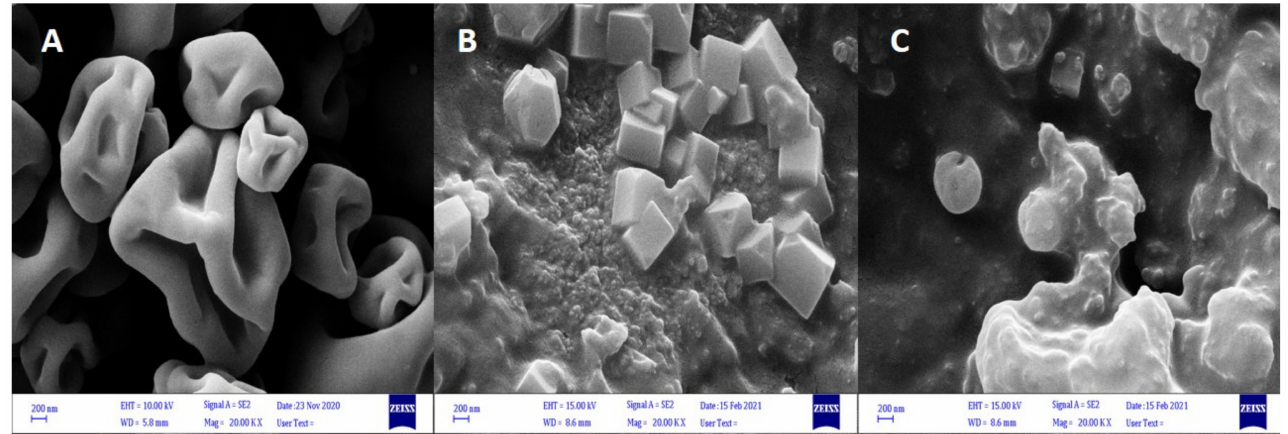
Figure 1. SEM micrographs of sodium alginate–whey protein–carbon nanotube (ALG–WP–CNT) microcapsules produced by ( A ): spray drying; ( B ): emulsification; ( C ):